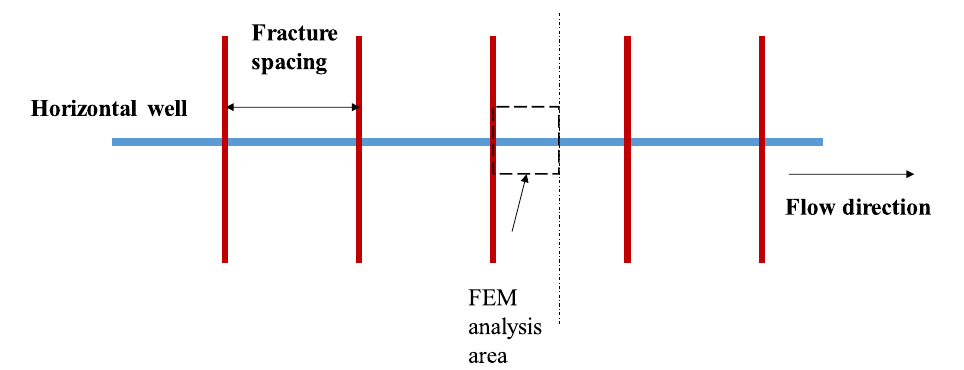
Figure 2. K - p correlations of the four types of shales.